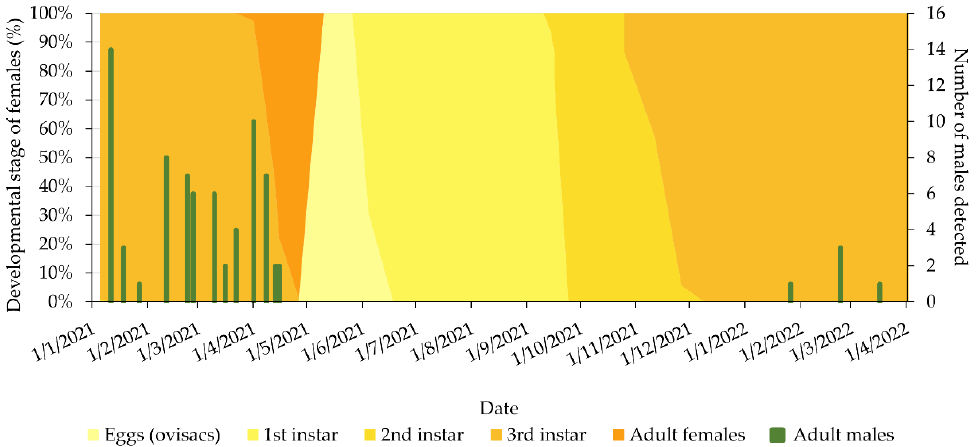
Figure 2. Percentage of the developmental stages of M. hellenica females (colored areas) and emer- gence of M. hellenica males (columns) in Kedrinos Lofos (Thessaloniki) between January 2021 and April 2022.